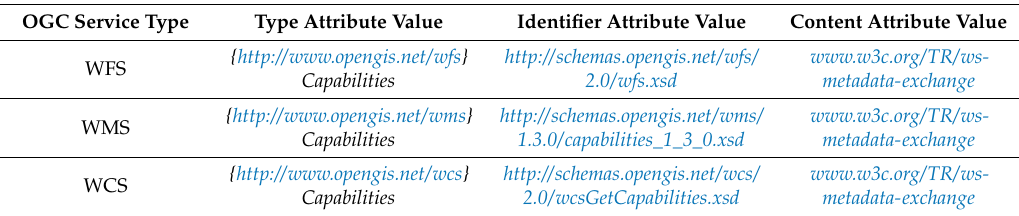
Table 1. New values for the Type and Identifier attributes to support the three main Open Geospatial Consortium (OGC)